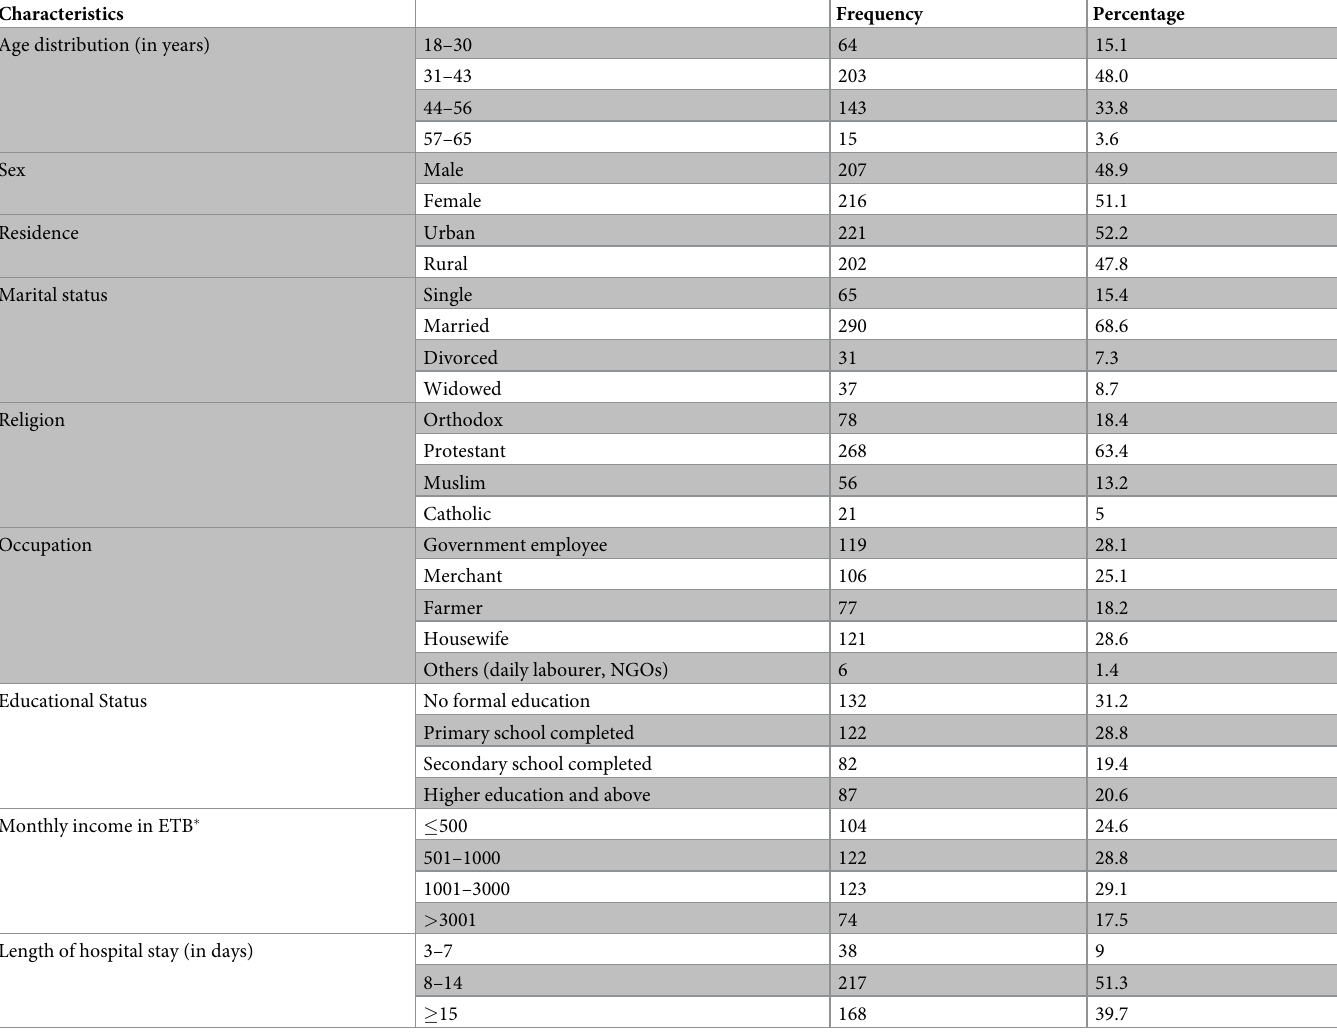
Table 1. Socio-demography characteristics of hospitals admitted adult patients at hospitals,